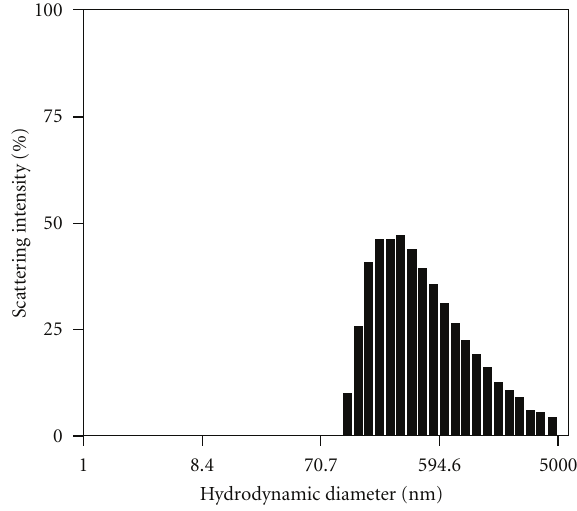
Figure 3: Scattering intensity distribution of the hydrodynamic diameter of P(POA- r -AA) with a 7/3 POA/AA ratio in hexafluoro- benzene at 25 ◦ C and θ = 90 ◦ . (copolymer) =